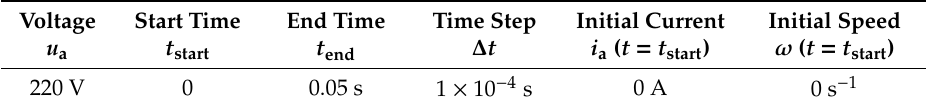
Table 2. Data used for the simulated input.